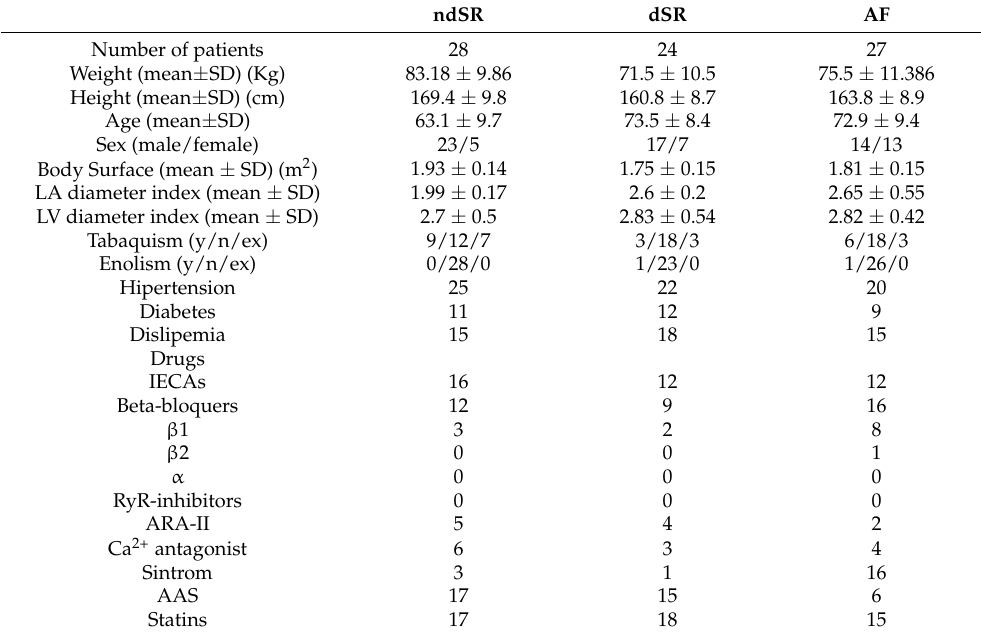
Figure 1. A 2A R expression in human right atrium. ( A ) Representative immunoblot showing the expression of A 2A R in right atrium from non-dilated sinus rhythm (ndSR) and atrial fibrillation (AF) patients; membranes from human atrium were analysed by SDS-PAGE (10 µ g of protein/lane) and immunoblotted using goat anti-A 2A R and rabbit anti- α -actinin antibodies (see Methods). ( B ) Relative quantification of A 2A R density; the immunoblot protein bands corresponding to A 2A R and α -actinin from ndSR ( n = 11) and AF ( n = 12) patients were quantified by densitometric scanning; values were normalized to the respective amount of α -actinin in each lane to correct for protein loading. ( C ) Relative expression of A 2A R transcripts in human atrium. Mean ± SEM from ndSR ( n = 11) and AF ( n = 9) patients. **** p < 0.0001 and ** p < 0.01, Student t test. Table 1. Patients’ clinical